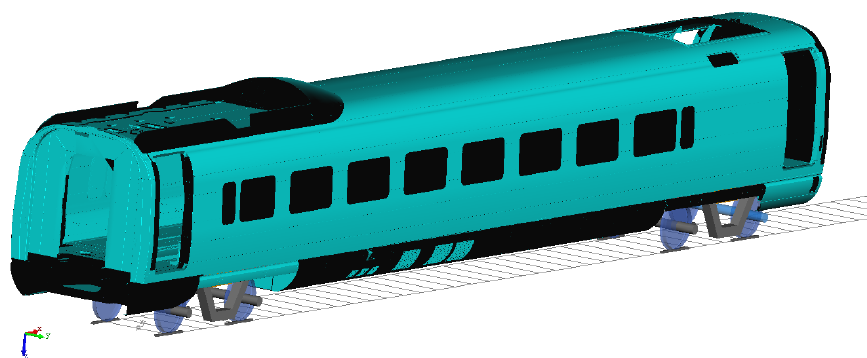
Figure 5. The train – track coupled rigid multibody dynamics model.